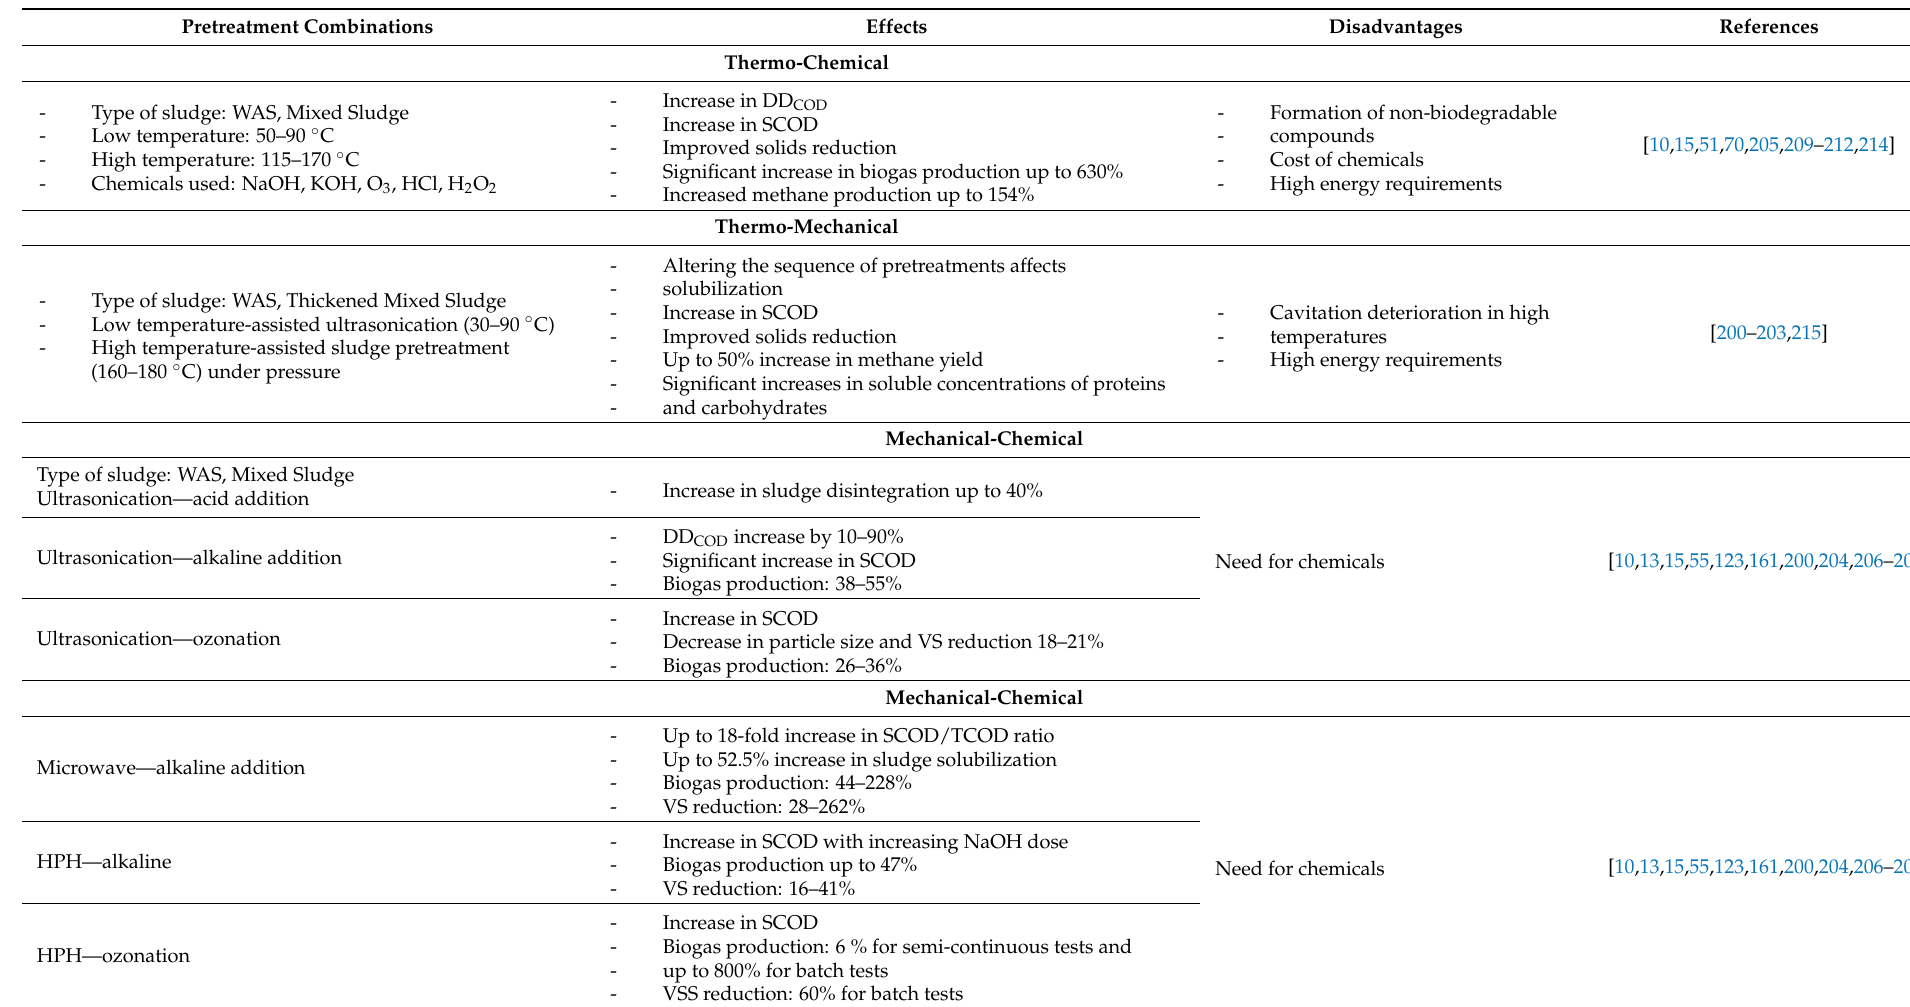
Table 5. Effects of combined pretreatment methods on anaerobic